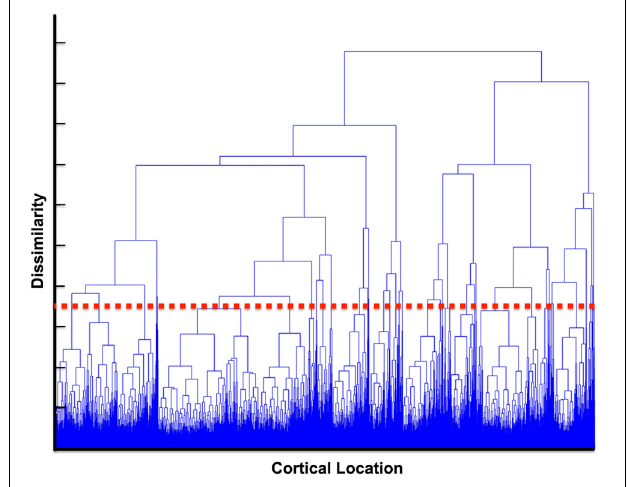
FIGURE 2 | Dendrogram of cluster similarity. The dendrogram was computed based upon iteratively aggregating clusters. On the y-axis the dissimilarity between clusters is displayed. For larger clusters (increased y-axis) the dissimilarity increases as clusters contain more diverse values. The red line indicates a choice of k for our k -means algorithm that provided tractable computationally complexity (increasing the number of clusters) vs. homogeneity of the values in the cluster.